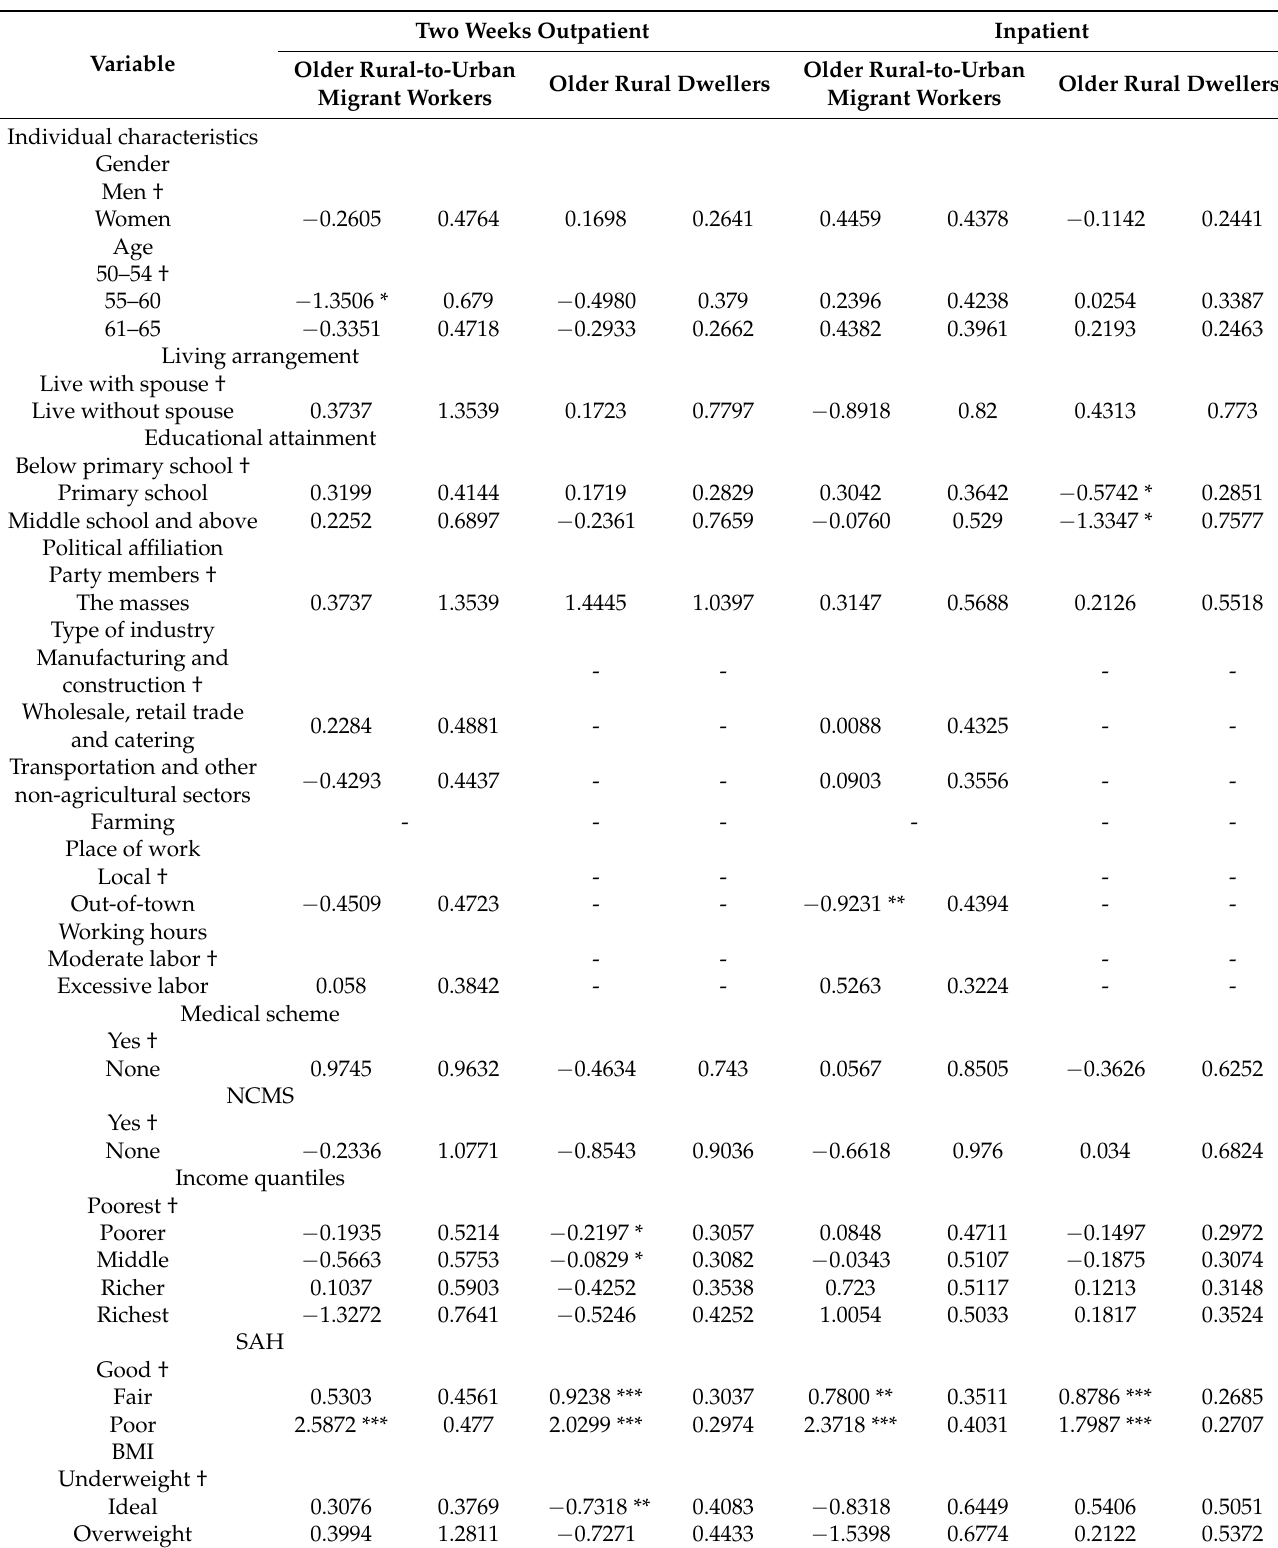
Table 2. Association of independent variables and health service utilization in logit regression